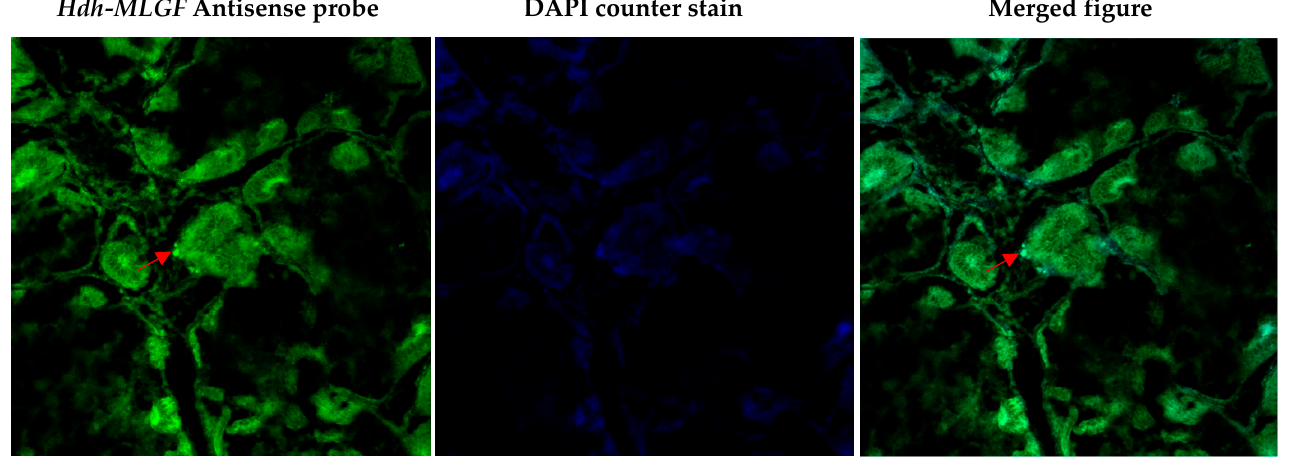
Figure 8. Tissue specific distribution of Hdh-MLGF and Hdh- β -Actin in the Pacific abalone, H. discus hannai.